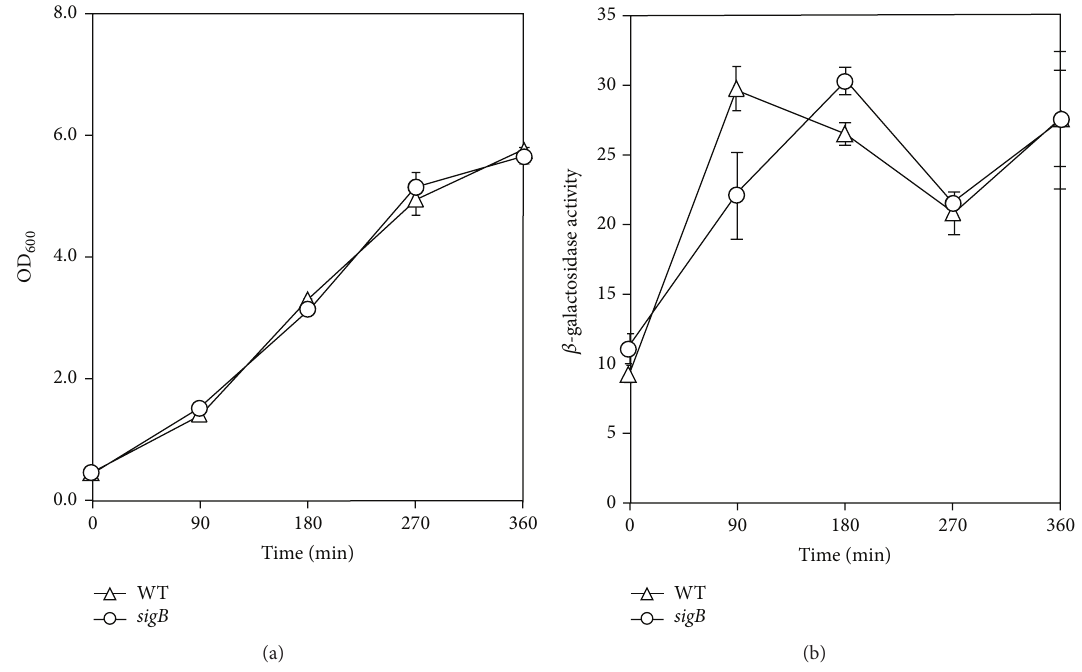
Figure 4: Regulation of msrA1/msrB locus in a methicillin-resistant S. aureus strain COL by SigB. The msrA1/msrB promoter- lacZ reporter strains were cultured in TSB and growth was measured as OD 600 (a). 𝛽 -galactosidase activity levels were measured in S. aureus strain COL (open triangles) and its derivative sigB mutant (closed squares) during different stages of growth (b). Values indicate averages of data from at least three independent experiments ± standard error ( ∗ significant at 𝑝 ≤ 0.05